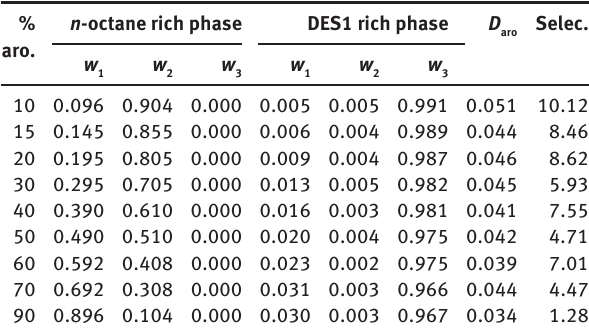
Table 2: LLE experimental data with DES1. % aro.